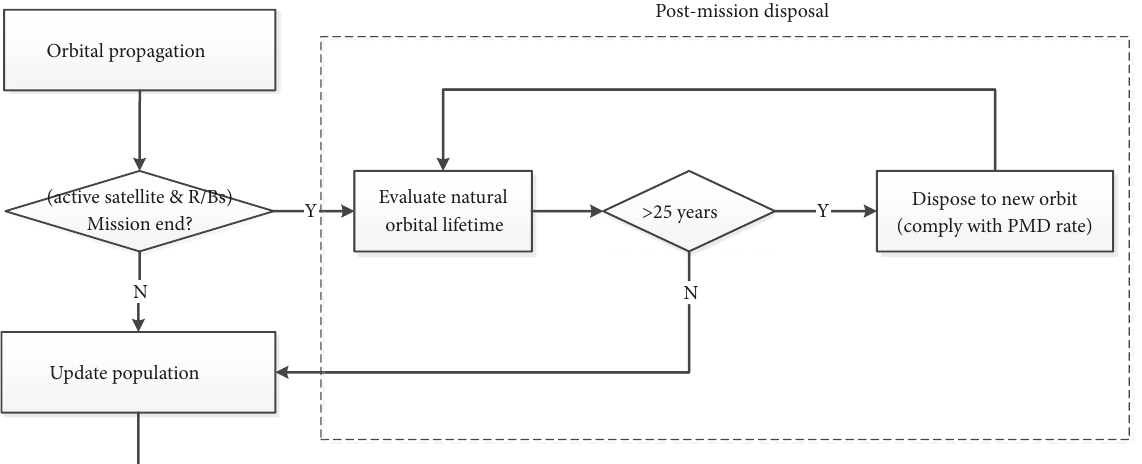
Figure 5: The procedure of PMD. For mission ended satellites or rockets (R/Bs), if the evaluated natural orbital lifetime exceeds 25 years, it will be disposed to a new orbit complying with the 25-year